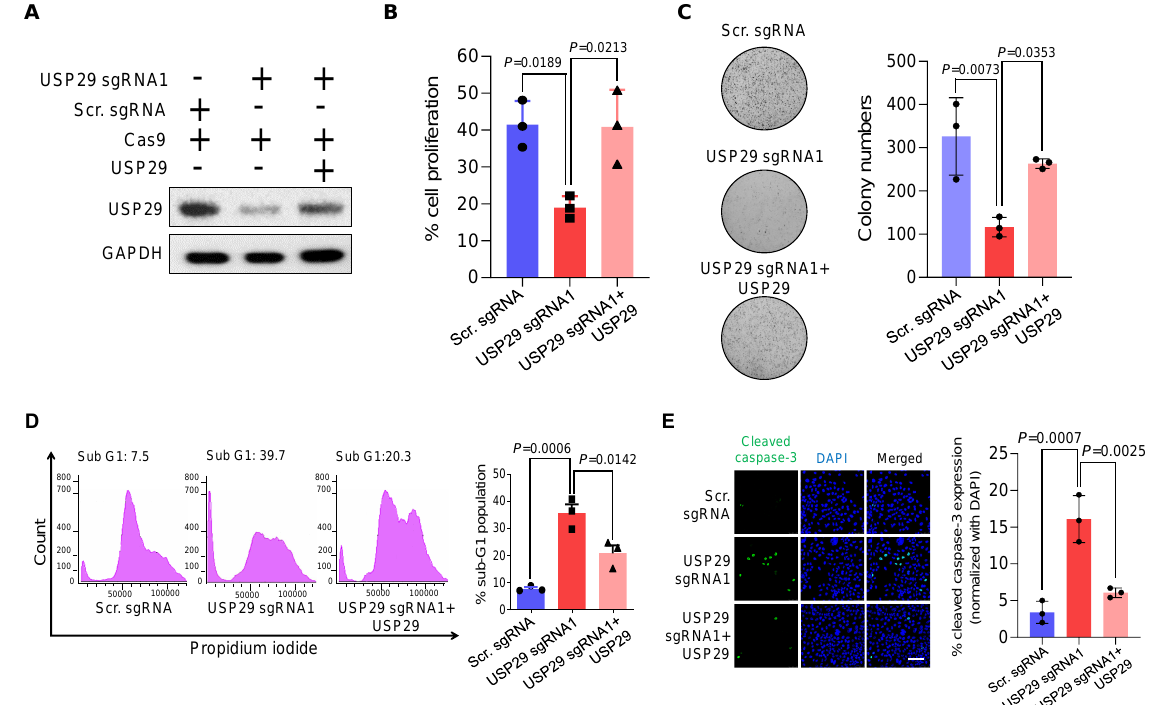
Figure 4. USP29-depleted HCT116 cells undergo apoptosis. ( A ) HCT116 cells were transfected with the indicated plasmids and Western blot analysis was performed with USP29-specific antibody. GAPDH was used as a loading control. ( B ) HCT116 cells were transfected with the indicated plasmids and subjected to a cell proliferation assay using a CCK-8 kit. ( C ) HCT116 cells were transfected with the indicated plasmids and subjected to a colony formation assay. The colonies were maintained for 14 days and stained with crystal violet to measure colony formation. The colony number quantified from the soft agar assay are presented in the right panel. ( D ) HCT116 cells were transfected with the indicated plasmids and stained with PI. Flow cytometry was performed to assess the apoptotic population. ( E ) HCT116 cells were transfected with the indicated plasmids and subjected to an immunofluorescence assay to analyze the expression of cleaved caspase-3. Scale bar = 50 µ m. Quantitative result for cleaved caspase-3-positive cells are represented in the right panel. Data in ( B – E ) are presented as the mean ± standard deviation of three independent trials. p -values were calculated using one-way ANOVA followed by Tukey’s post hoc